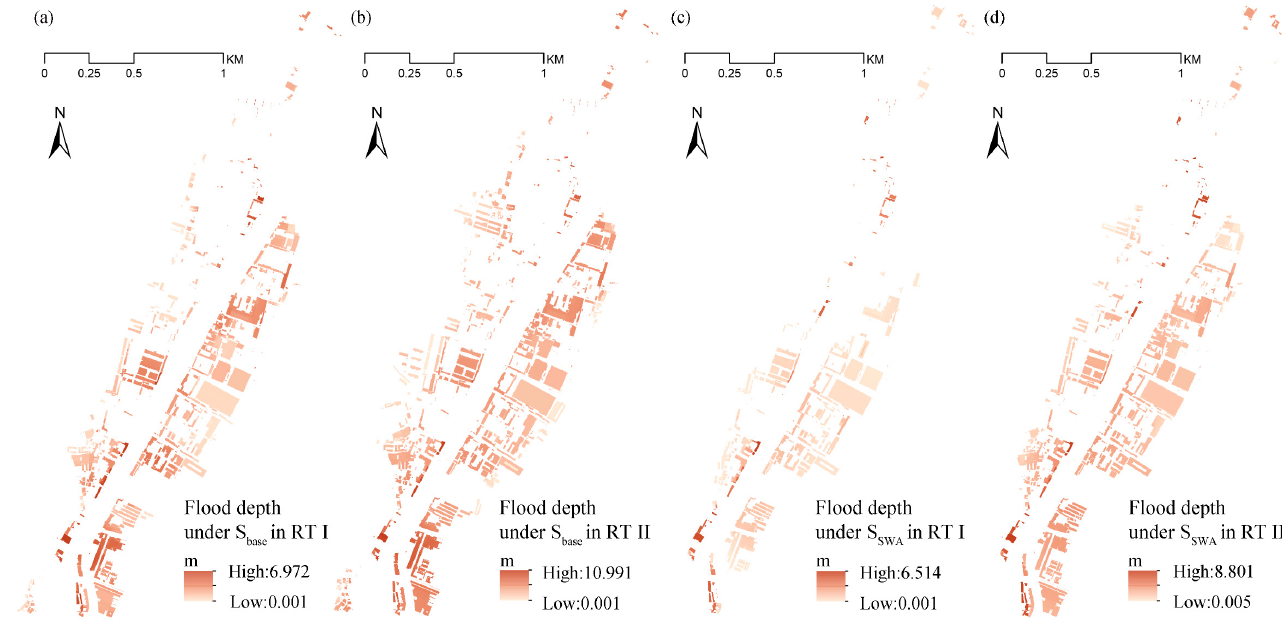
Figure 15. The inundation depth of each building under different scenarios in RT I and RT II. ( a ) S base in RT I; ( b ) S base in RT II; ( c ) S SWA in RT I; ( d ) S SWA in RT II.